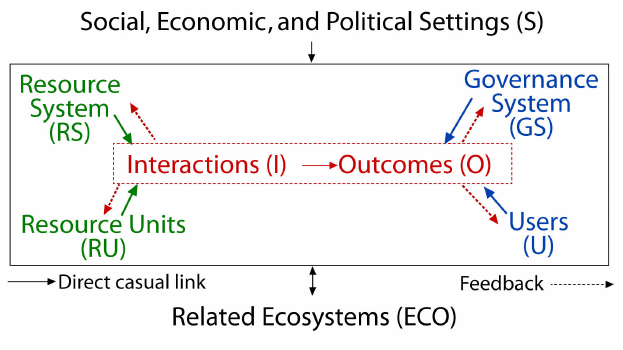
Fig. 4 . A general framework for the highest-tier variables that scholars need to analyze when examining linked social- ecological systems. Source: Based on and modified from Ostrom